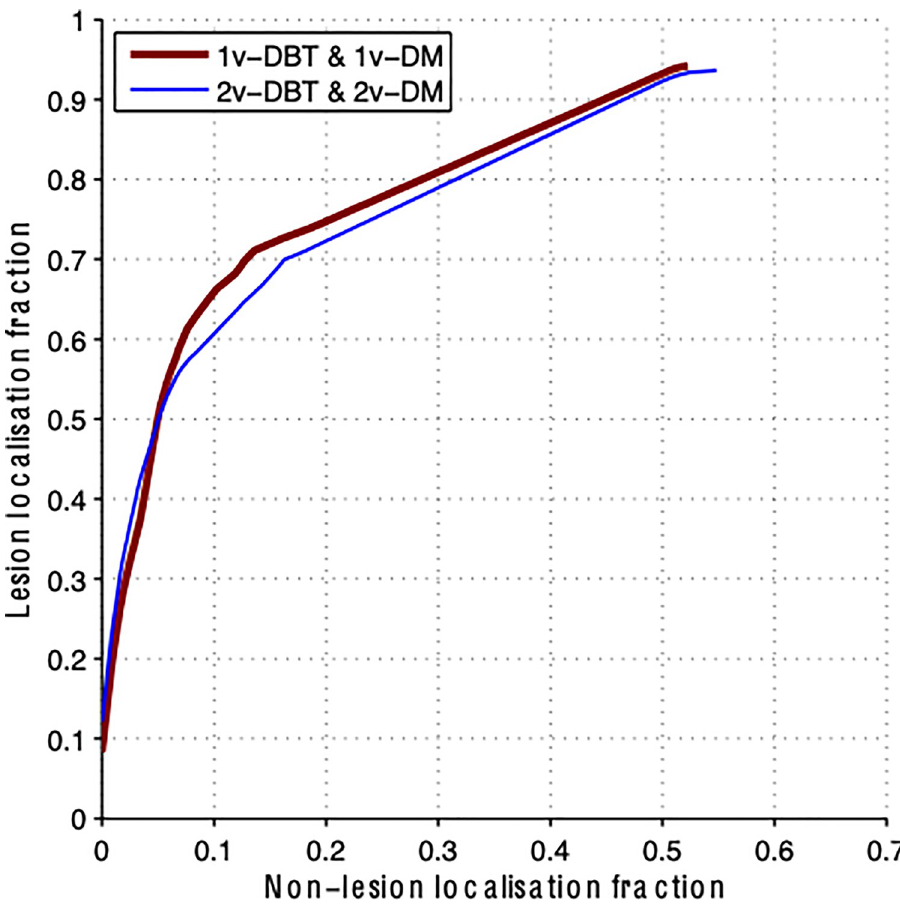
Fig 2. JAFROC analysis averaged for all readers for the two DBT implementations assessed: 1vDMT&1vDBT in red and 2vDMT&2vDBT in blue. The lesion localization fraction is the number of correctly identified lesions divided by the total number of lesions and the non-lesion localization fraction is the number of marks which are not close to any lesions, divided by the total number of images.